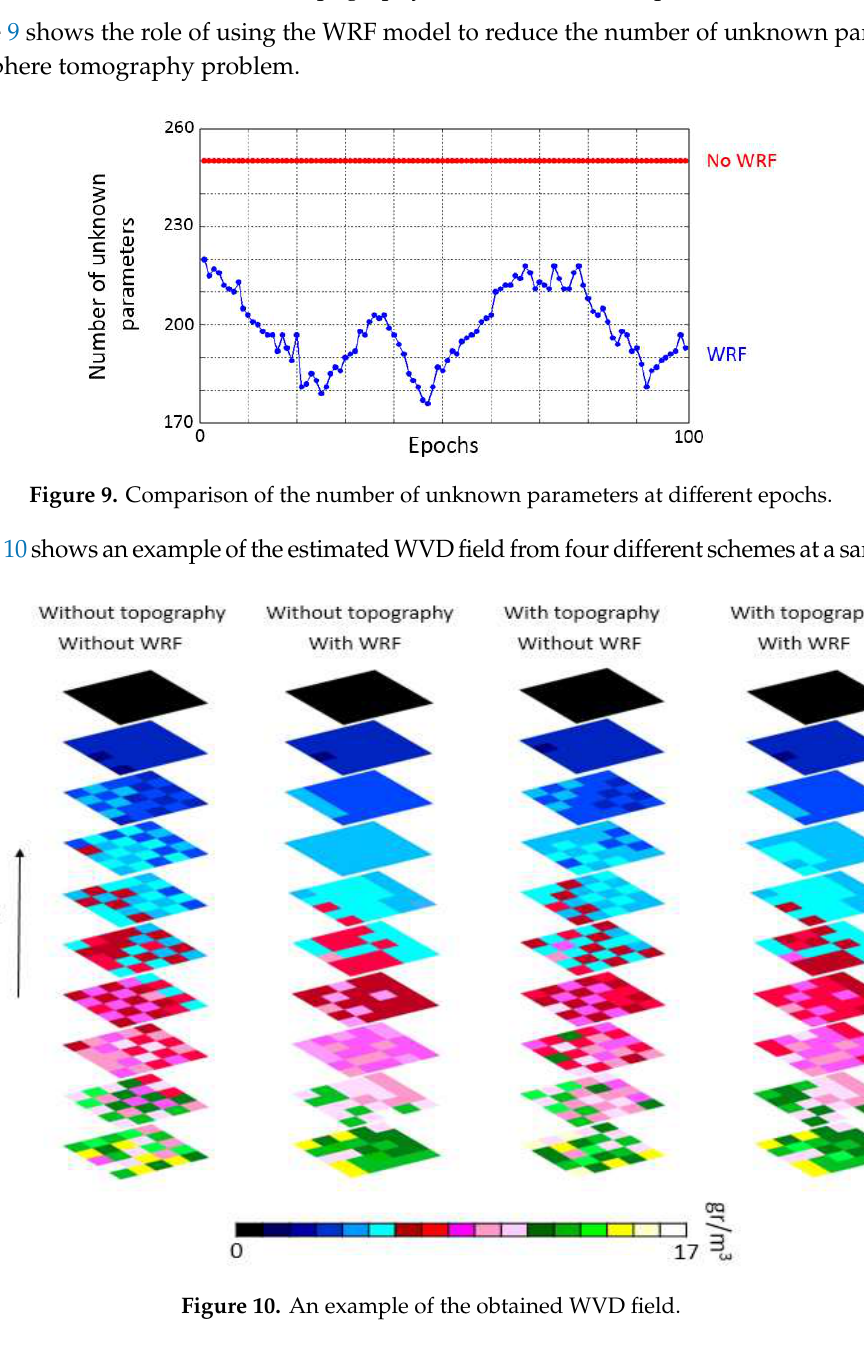
Figure 11 . Two examples of comparison between the obtained WVD and radiosonde observations .